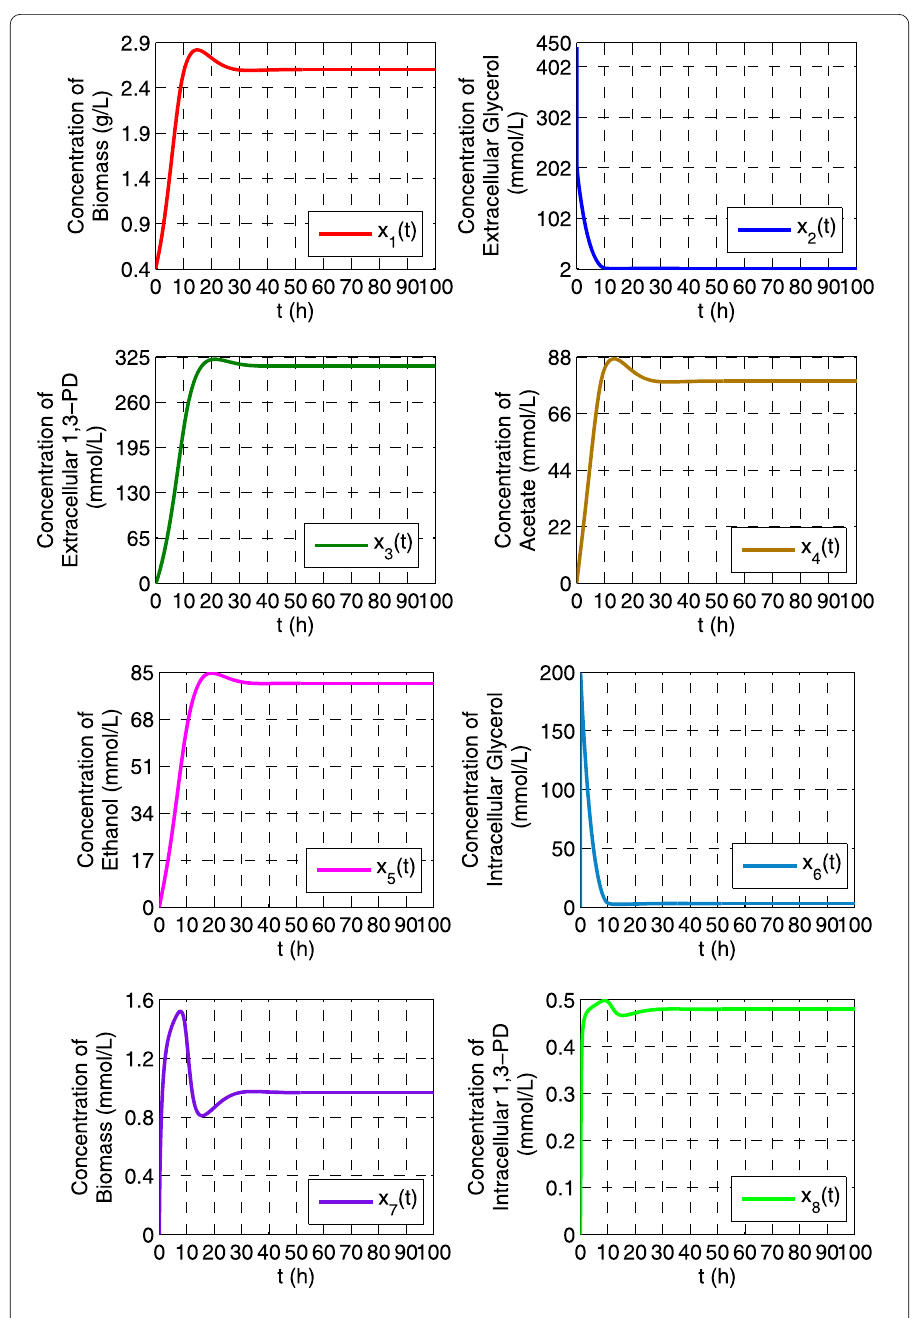
Figure 1 Change of the state variable x ( t ) with t ∈ [0,100].